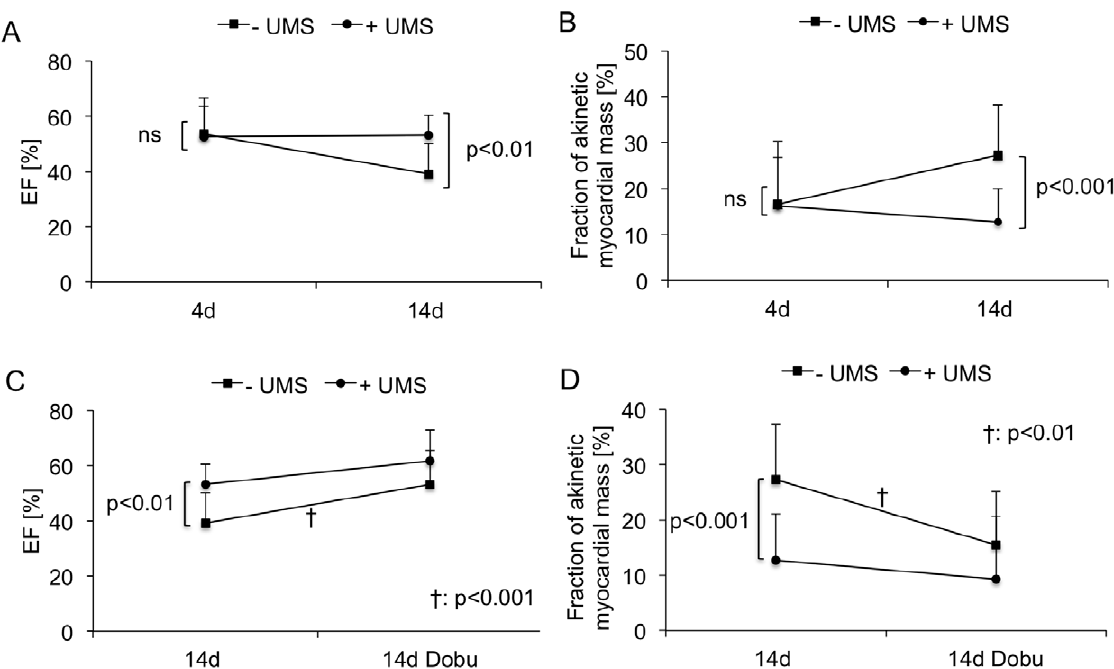
Figure 4. Global and regional left-ventricular function. (A) Mean left-ventricular ejection fraction (LV-EF) was moderately reduced four days after acute myocardial infarction and reperfusion (AMI/R) prior to ultrasound-mediated stimulation of microbubbles (UMS) in both groups. (B) Regional LV-function was quantified by means of reconstructive 3-dimensional echocardiography (r3DE) and is expressed as fraction of akinetic myocardial mass. UMS-treated animals (circles) demonstrated functional improvement two weeks after AMI/R, as compared to controls (squares). (C, D) Global and regional LV-function were obtained prior and during pharmacological stimulation with low-dose dobutamine on day + 14. Inotropic response was preserved in both groups and revealed a significant increase in LV-EF and decrease in fraction of akinetic myocardial mass. Both non- invasive measures are parameters indicating preserved myocardial viability after AMI and reperfusion. In all, UMS improved LV-function after AMIR/R without impact on myocardial